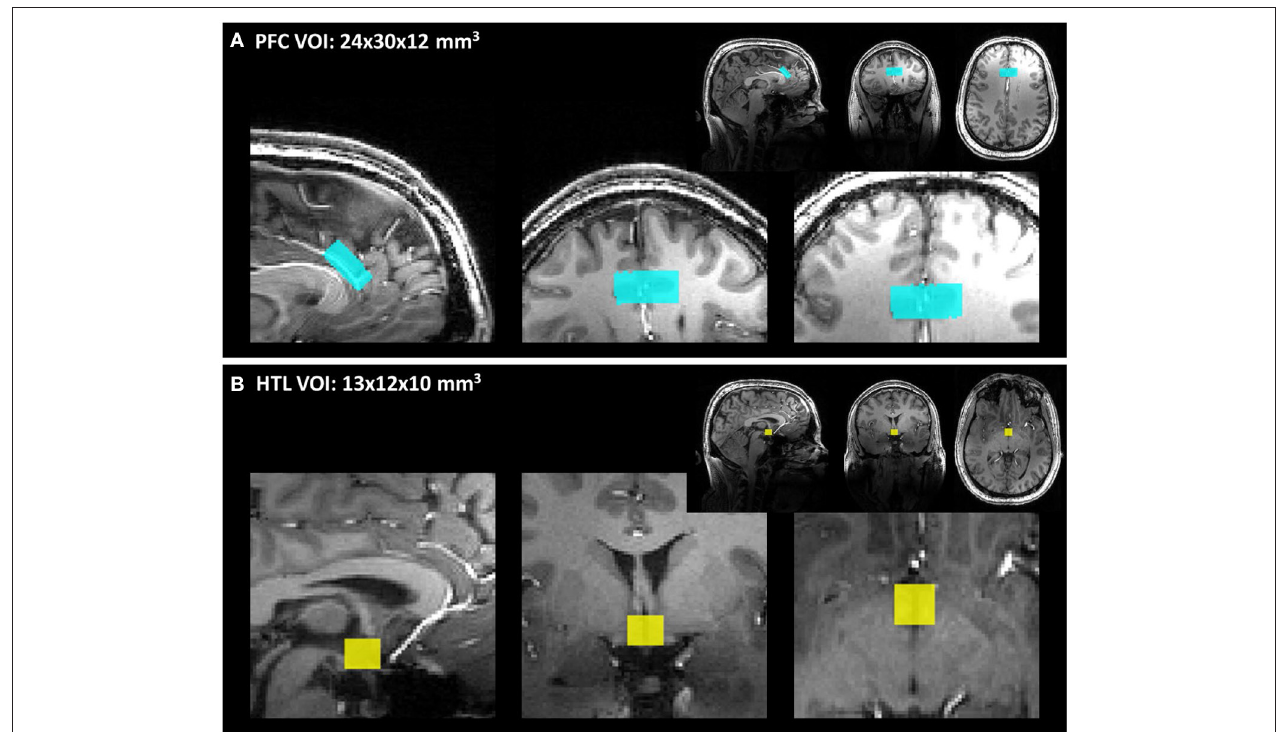
FIGURE 3 | Overview of magnetic resonance spectroscopy (MRS) data acquisition during glucose clamps where the same set of data is acquired during euglycemia and hypoglycemia.